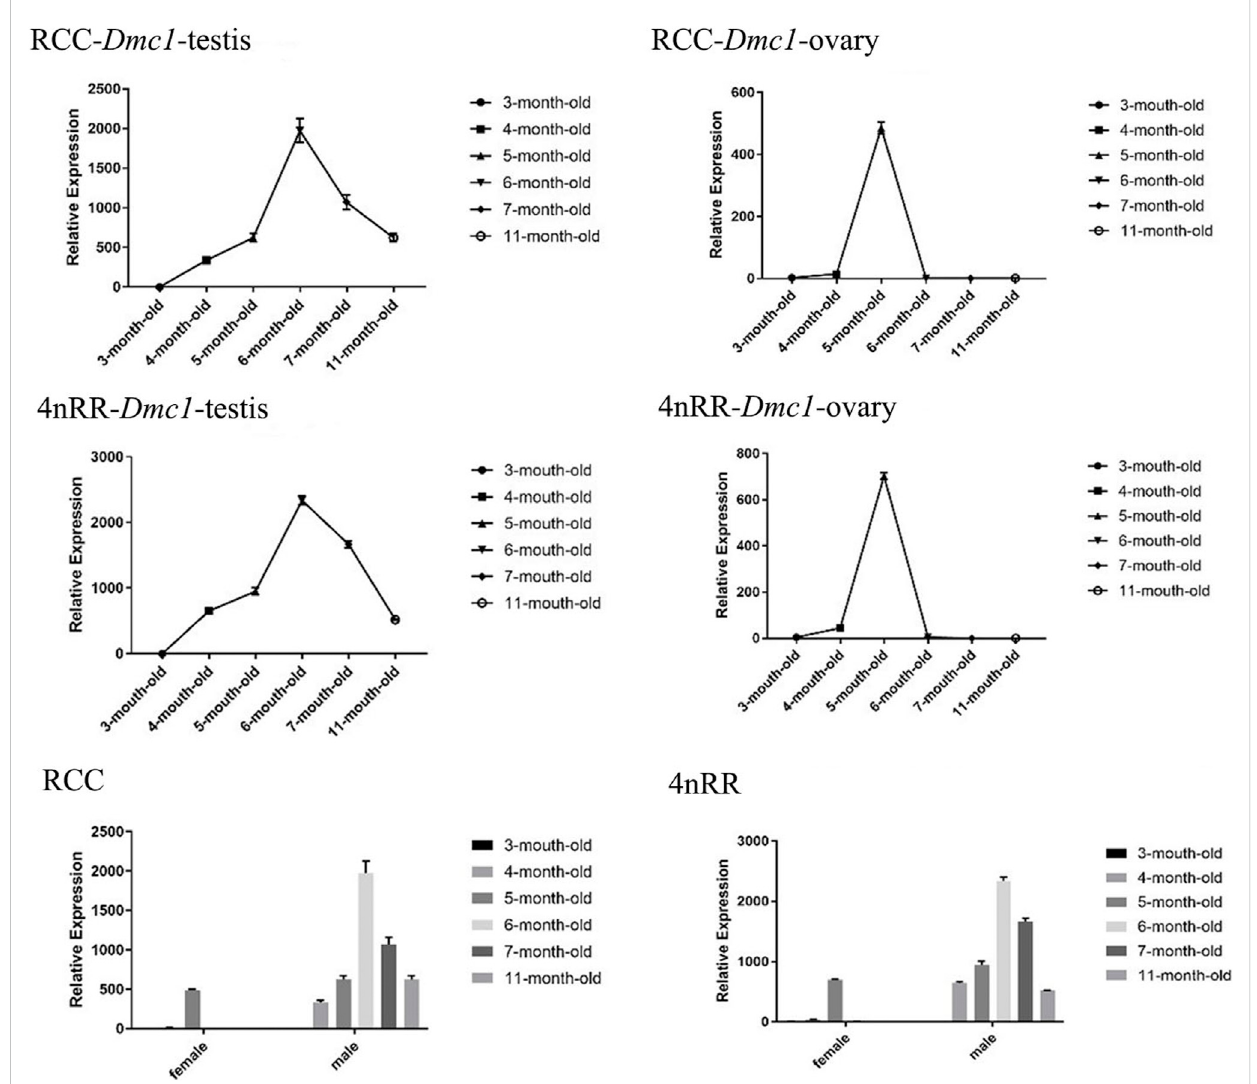
FIGURE 4 Relativeexpressionlevelsof Dmc1 ofRCCand4nRRatdifferentagestages(3,4,5,6,7,and11-month-old)offemalesandmales,andthedifferential expression characteristics between females and males in RCC and